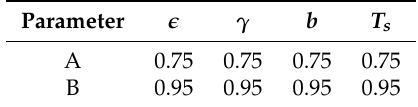
Table 4. Parameter values used for intervention